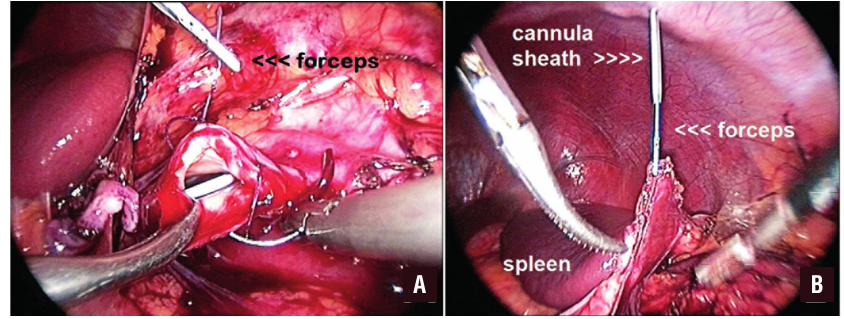
Figure 2 - (A) A 5F forceps that is inserted inside of the Iv cannula sheath is used to retract anastomosis line during suturing. (B) A 5F forceps that is inserted inside of the Iv cannula sheath is used to retract spleen during left renal laparoscopic surgery. video presentation: The video presentation shows details of antegrade double-J placement during laparoscopic pyeloplasty by 14 gauge intravenous cannula sheath, and also shows the use of intravenous cannula sheath as a trocar to retract an organ or reveal an anastomosis line during laparoscopic urologic